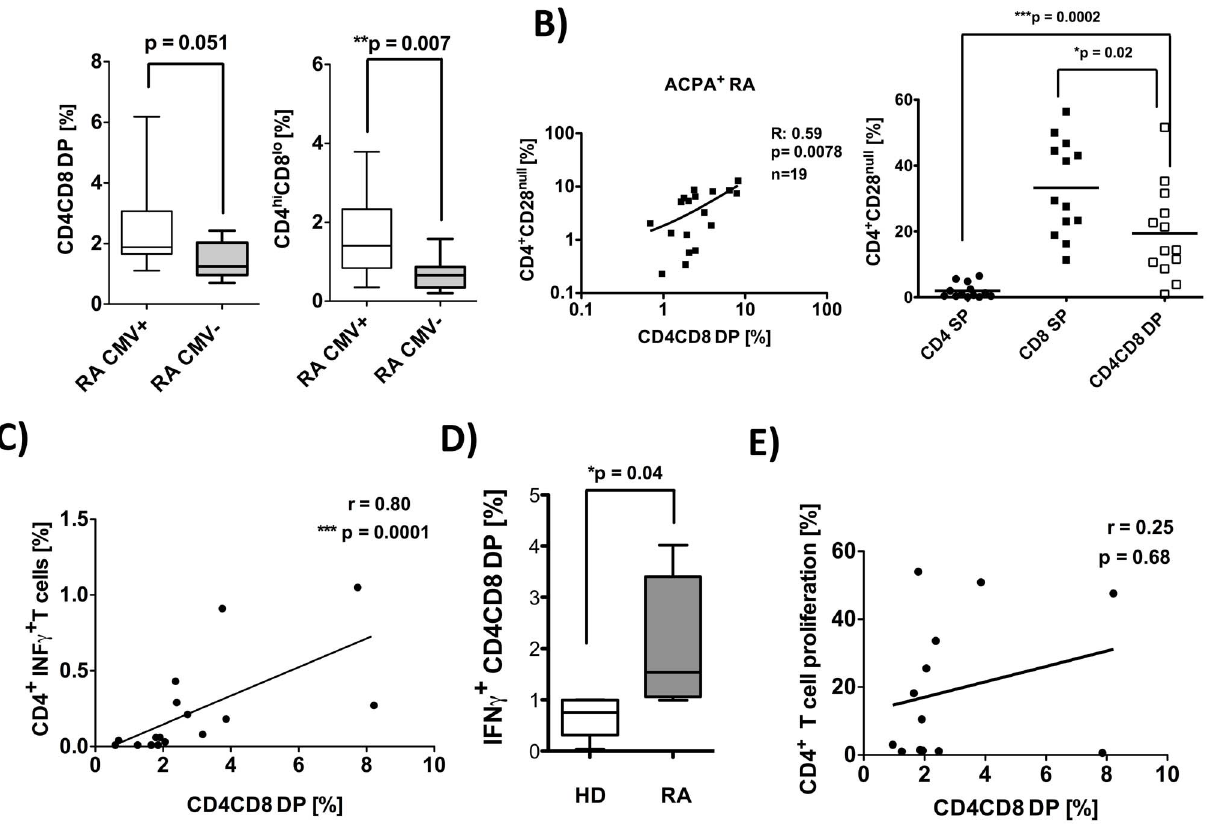
Figure 6. Frequencies of CD4CD8 double positive T cells are increased in CMV positive RA patients and correlate with CMV specific INF c producers. A) PBMC were isolated from CMV + RA patients (n=28) and CMV 2 RA patients (n=12) and analyzed by flow cytometry using anti- CD19, anti-CD3, anti-CD4 and anti-CD8 monoclonal antibodies (PI staining used for exclusion of dead cells). B) Correlation of the frequency of total double positive T cells with CD4 + CD28 null T cells in ACPA + RA patients (left graph) and comparison of frequencies of CD28 null cells among CD4 SP, CD8 SP and total DP T cells (right graph). C–D) PBMCs were restimulated with CMV-lysate for 4 hrs in vitro. Subsequently, an INF c specific secretion assay was performed and cells were counterstained with aCD3, aCD4 and aCD8. Flow cytometric cytokine analyses were performed on live cells (PI staining used for exclusion of dead cells) pre-gated on CD3 + T cells. C) Depicted is the c orrelation of CMV specific INF c producing CD4 T cells with the frequencies of CD4CD8 DP cells from the same donor (n=16). D) CMV specific INF c producing CD4CD8 DP T cells from RA (n=5) and HD (n=5) are shown. E) PBMCs were labeled with CFDA-SE and restimulated with CMV-lysat (n=13) for 7 d in vitro. Depicted is the c orrelation of CMV specific CD4 T cell proliferation with the frequencies of CD4CD8 DP cells from the same donor. Presented box plots show median, interquartile range, and 10–90 percentiles. Significance as given, *p , 0.05, **p , 0.01, ***p , 0.001.